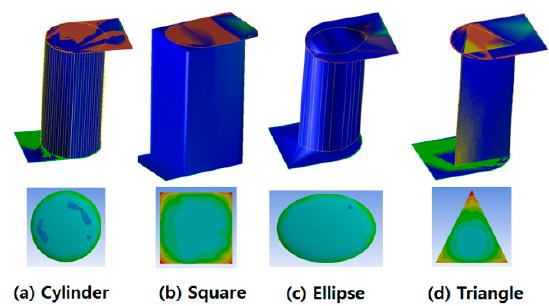
ff erent TSV shapes considered in the Figure 4. Different TSV shapes considered in the simulation. Figure 4. Di